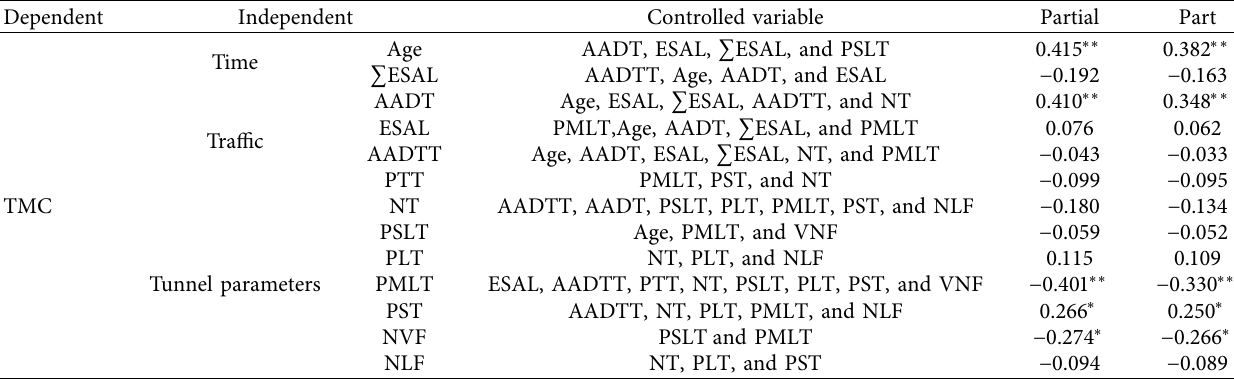
Table 3: Partial and part correlation analysis.